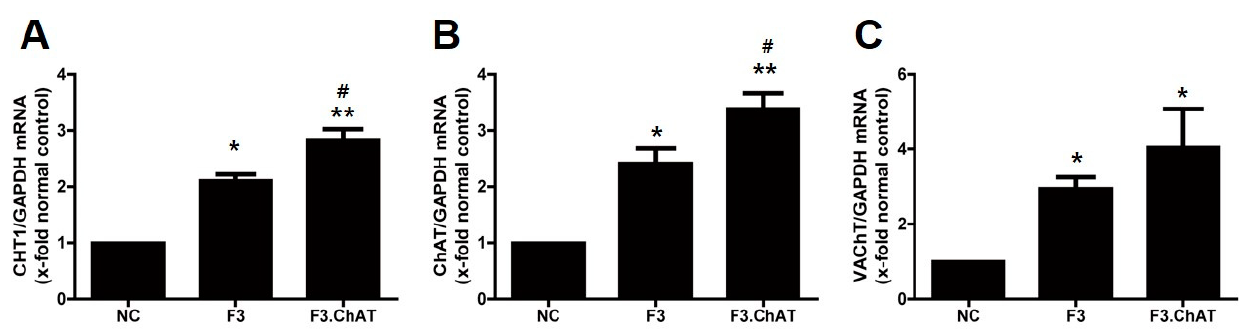
Figure 5. Expression of CHT1 ( A ), ChAT ( B ), and VAChT ( C ) in primary forebrain neurons co-cul- tured with F3 and F3.ChAT cells. The F3 and F3.ChAT cells were seeded at 1 × 10 5 cells per ml in the upper chambers of 6-well transwell plates (pore 0.4 μ m) on the primary forebrain neuron. After a 24 h incubation, the cells were used for performing real time PCR. * Significantly different from normal control ( p < 0.05). ** Significantly different from the normal control ( p < 0.005). # Significantly different from the F3 ( p < 0.05).